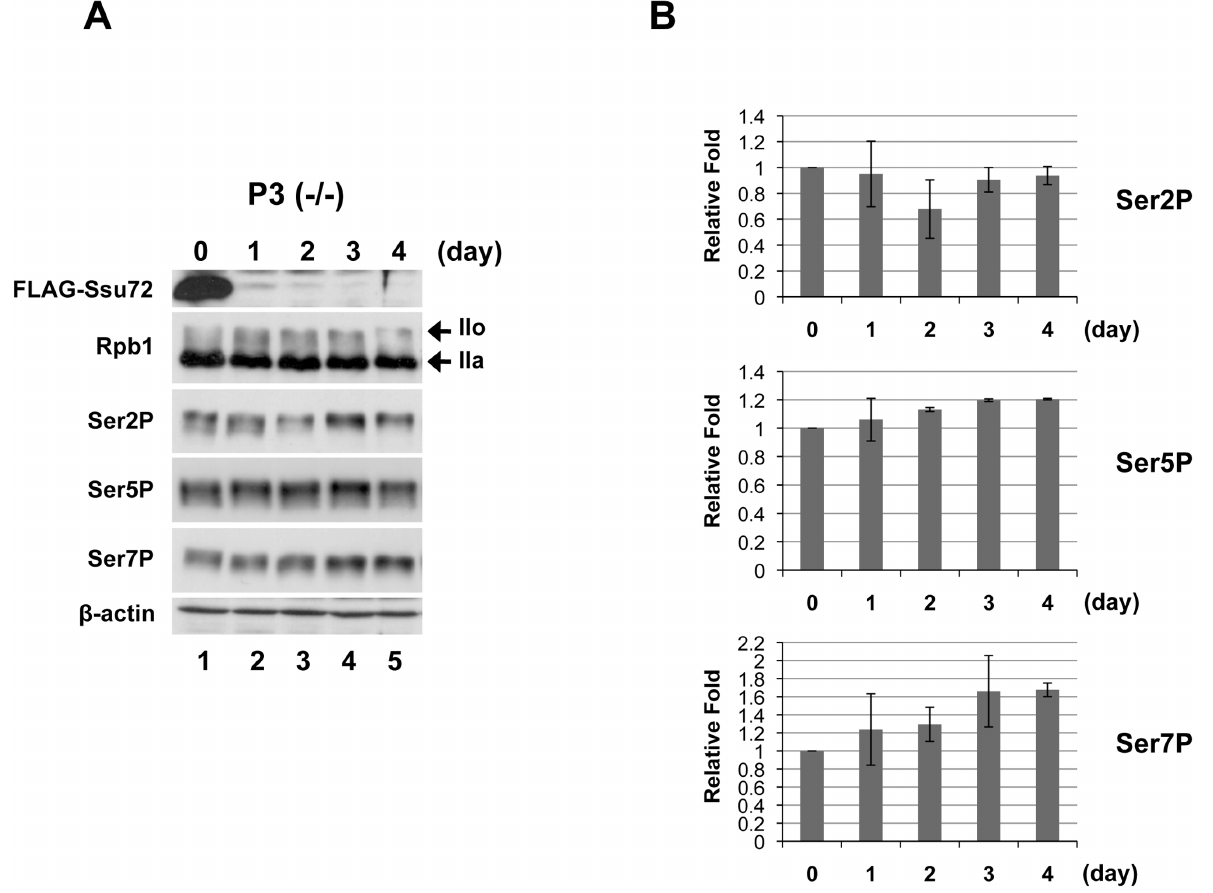
Figure 3. Ssu72 depletion results in a modest increase in CTD phosphorylation. (A) Whole-cell extracts from DT40 P3 ( 2 / 2 ) cells treated with Dox for the indicated number of days were separated by SDS-PAGE, and then analyzed by Immunoblotting with antibodies against FLAG-Ssu72 (anti-FLAG M2), the largest subunit (Rpb1) of Pol II (N20), Ser2P (3E10), Ser5P (3E8), Ser7P (4E12), and b -actin. Western blotting of b -actin was used to confirm equal protein loading. The positions corresponding to the hyper-phosphorylated form of Rpb1 (IIo) and hypo-phosphorylated form of Rpb1 (IIa) are indicated by arrows. (B) Fold change of phosphorylation levels of each serine (Ser2/5/7P) relative to the corresponding levels on day 0. The Western blot signals were quantified by using a luminescent image analyzer LAS-4000 mini (Fujifilm). The each value was normalized by total Pol II signal (Rpb1). Error bars represent standard deviations of two independent experiments.